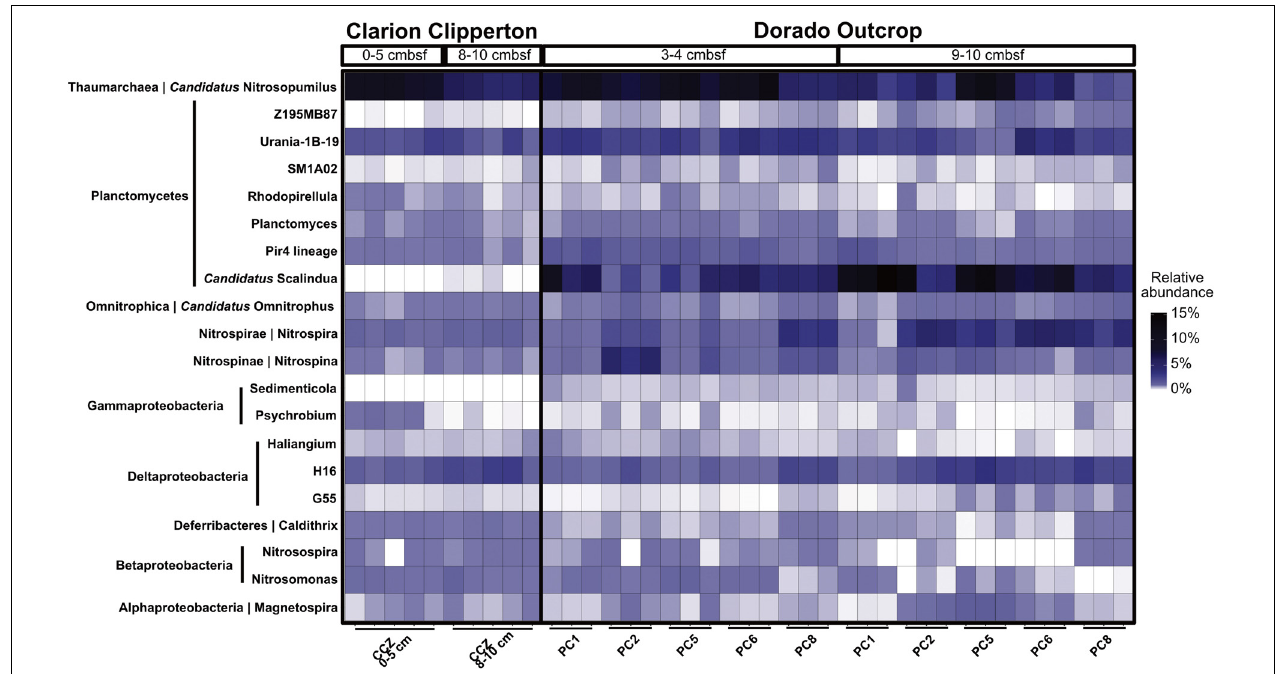
FIGURE 7 | Relative abundance of genera in Clarion Clipperton Zone sediments and Dorado Outcrop hydrothermal sediments, at 0–5 cmbsf and 8–10 cmbsf for the Clarion Clipperton Zone, and 3–4 cmbsf and 9–10 cmbsf for the Dorado Outcrop sediments. Phylum is labeled to the left of the genus name along the y -axis.